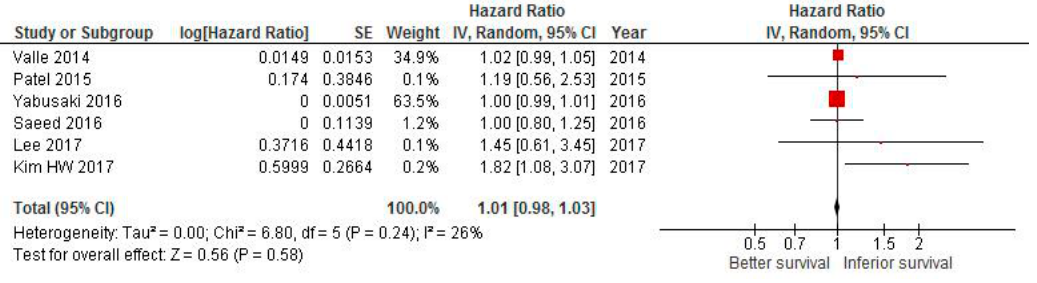
Figure 3. Forest plot of association between delay of adjuvant chemotherapy beyond 6–8 weeks and survival in pancreatic cancer. survival in pancreatic